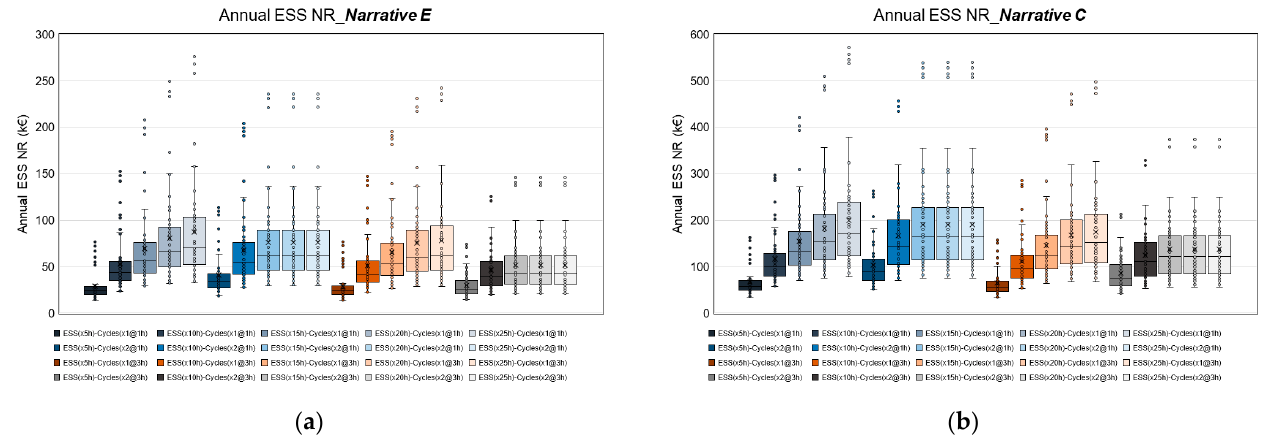
Figure 13. Wind-supported ESS market participation for independent actors and an individual wind-storage actor; annual NR of the storage component for SCF = 50% ( a ) and SCF = 0% ( b ) per di ff erent storage con fi guration and cycling option.